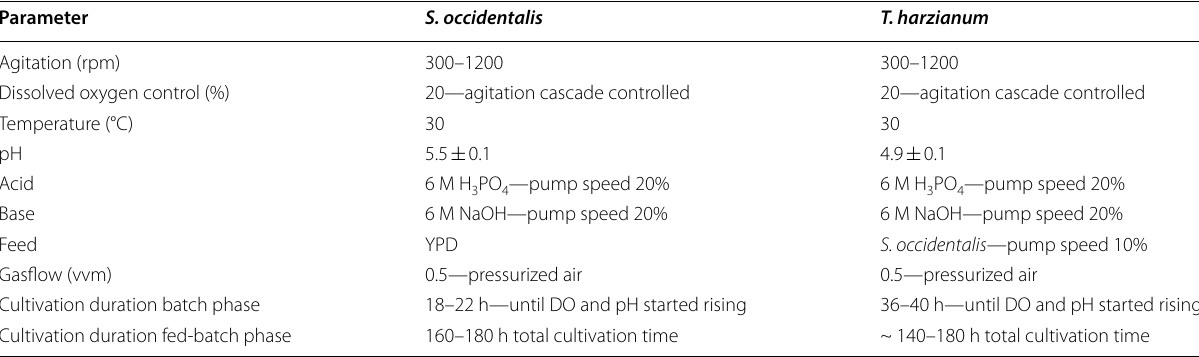
Table 1 Parameters used for the bioreactor cultivations of Schwanniomyces occidentalis and Trichoderma harzianum